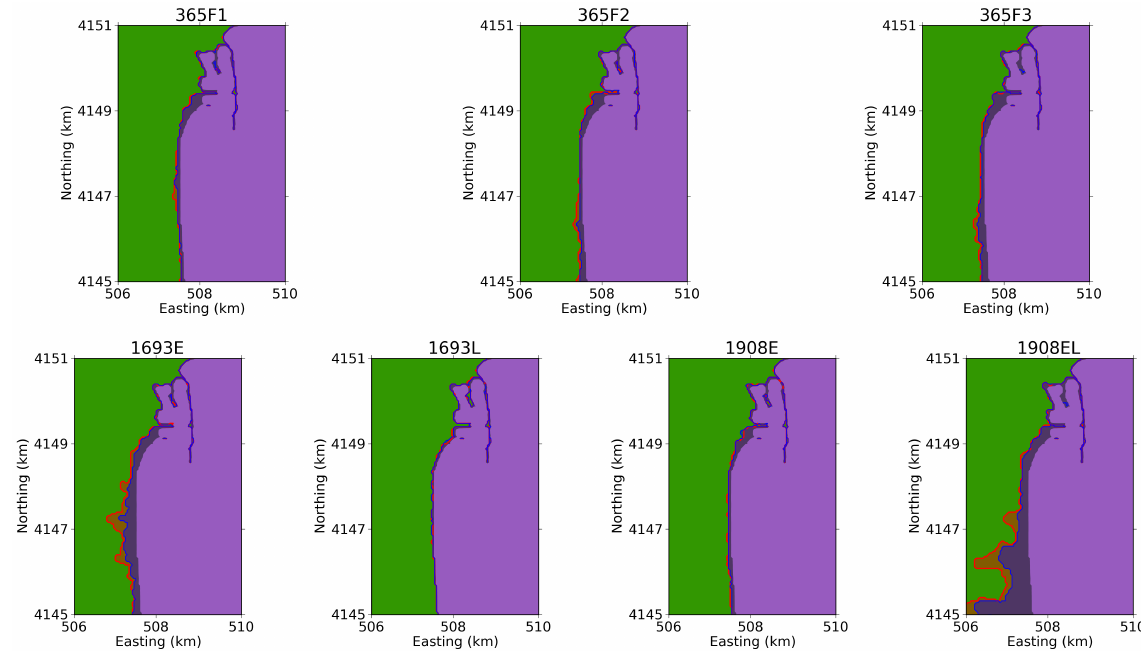
Fig. 12. Maximum inundation lines obtained for each one of the seven scenarios analysed: the blue ones are the inundation lines correspond- ing to the standard cases, while the inundation obtained by the augmented scenarios are delimited in